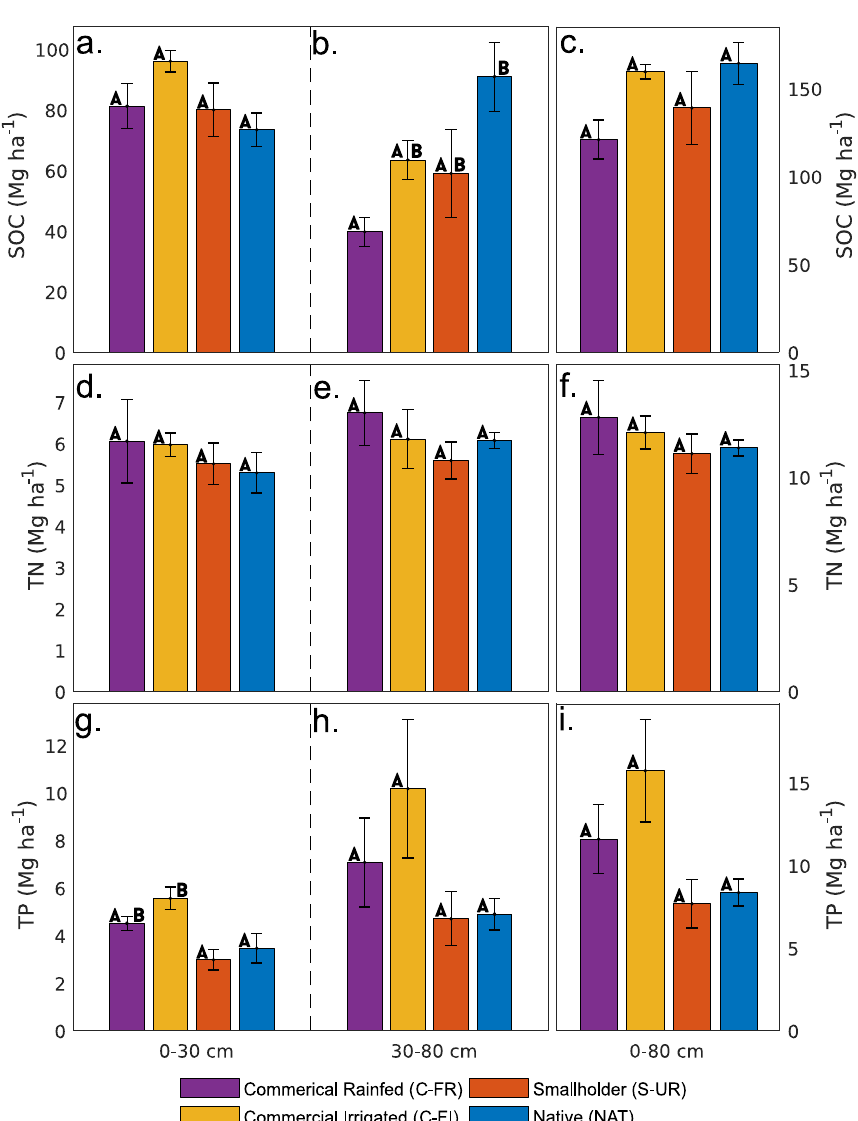
Figure 3. Stocks of SOC ( a–c ), TN ( d–f ) and TP ( g–i ) for: left, 0–30 cm, center 30–80 cm from the soil surface; right, 0–80 cm from the soil surface. Note the different vertical scales between the two left columns and the right one; black whiskers are standard errors (n = 5). Different letters (A or B) above bars represent significant difference ( p < 0.05) between LMPs determined using one-way analysis of variance and Tukey's honestly significant difference post hoc test.